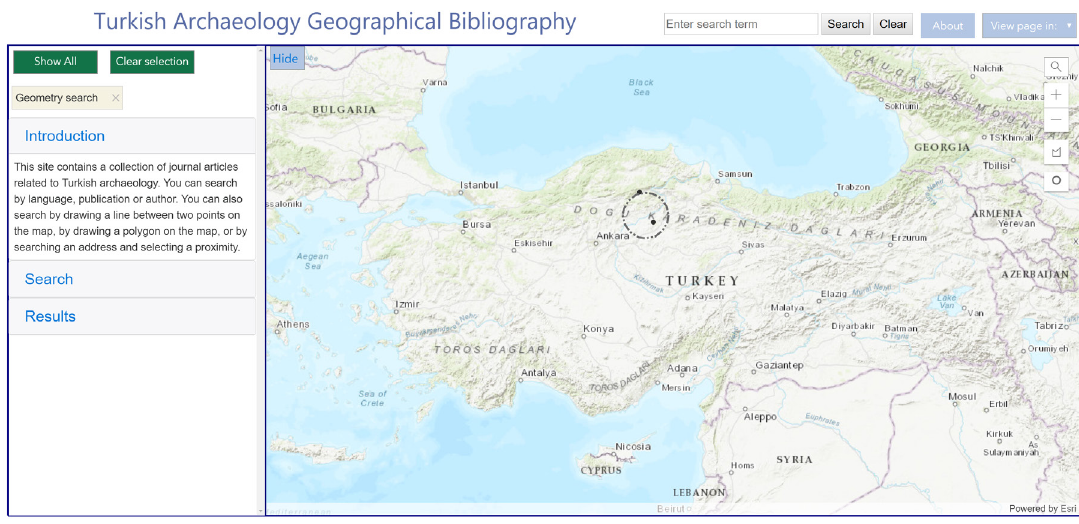
Figure 4. Mapped bibliography landing page with a circle designating the parameters of a geographic